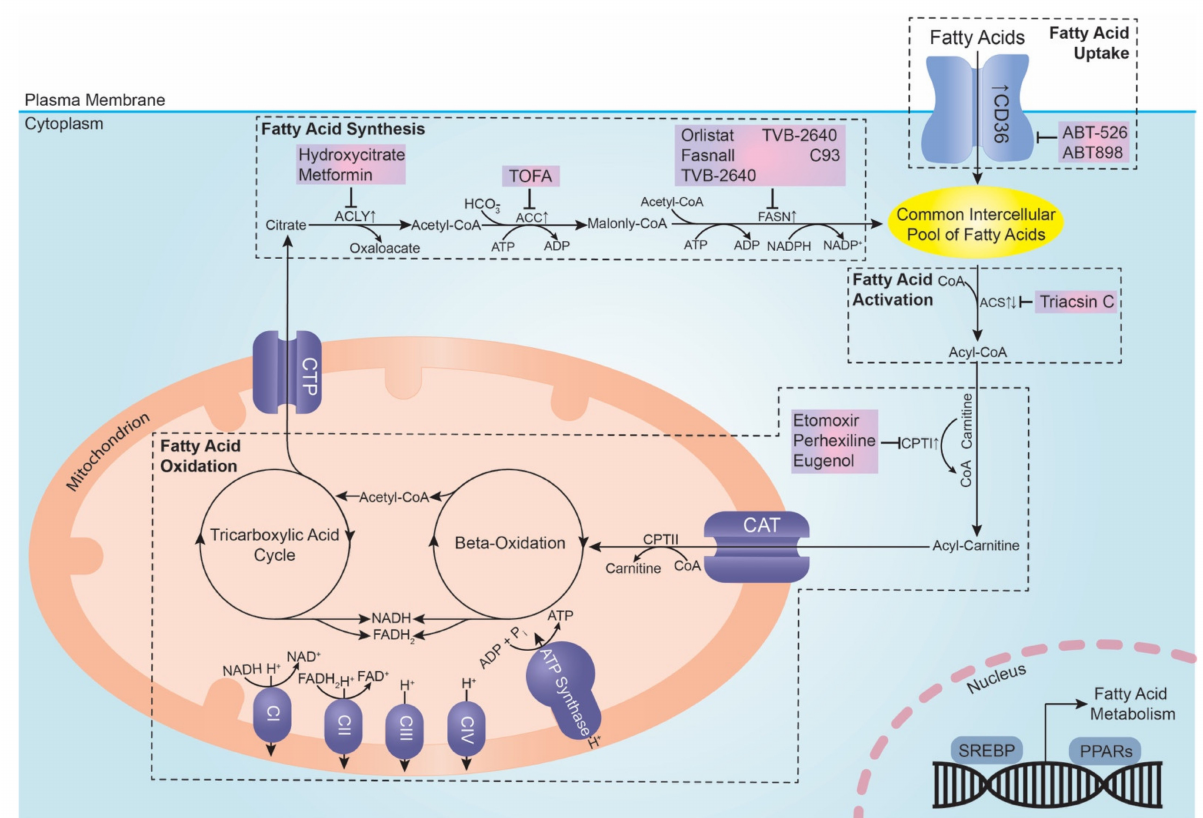
Figure 1. Overview of the various aspects of fatty acid metabolism and their dysregulation in gynaecological cancers. Fatty acids can be produced via de novo synthesis using citrate-derived acetyl-CoA or obtained exogenously through CD36. They are then activated to produce acyl-CoAs which are then transported into the mitochondrion to undergo beta-oxidation, producing NADH, FADH2 and acetyl-CoA all of which are used to synthesise ATP via the TCA cycle and ETC. Fatty